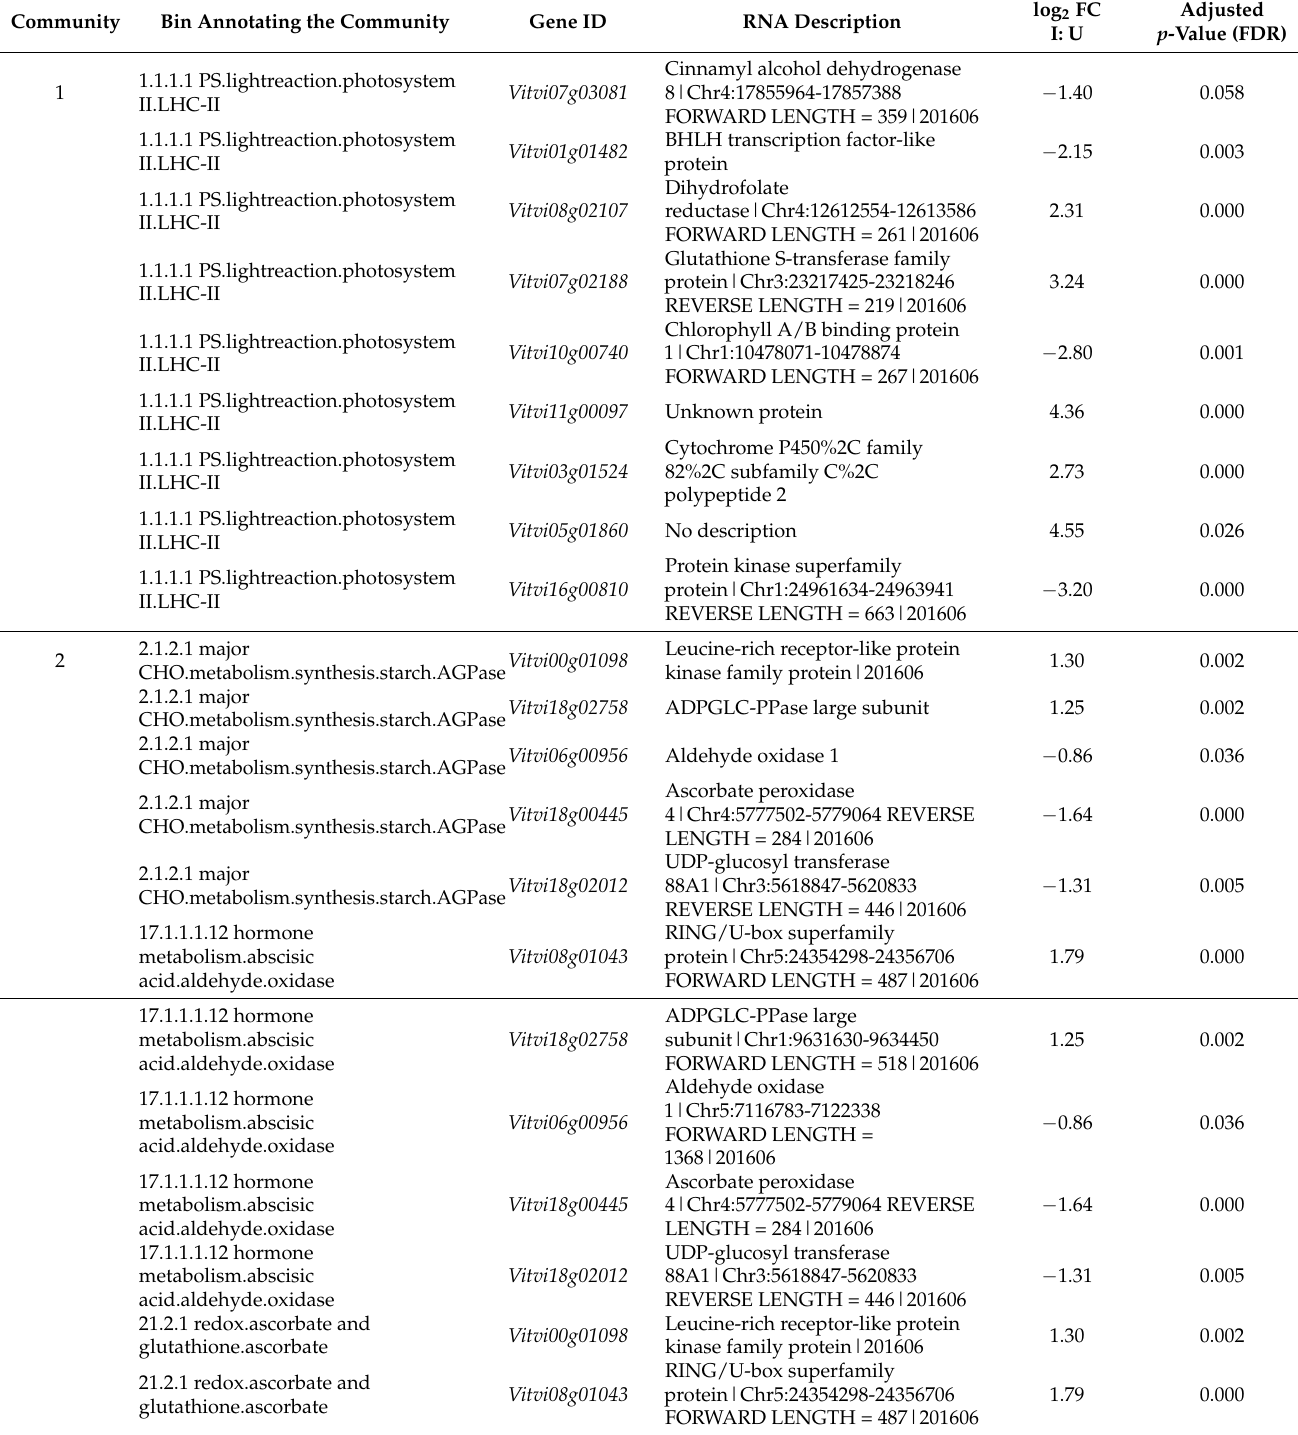
Table 1. Examples of the enriched communities with a direction of analysis from infected to uninfected grapevines late in the growing season, where the dissipation index was 0.48. Each community was annotated with the members from the GoMapMan ontology [38], providing direct insight into their associated processes. The analysed data were differentially expressed genes from uninfected grapevines cv. Zweigelt and from samples infected with ‘ Ca. P. solani’. For each mRNA sequence, the differences in expression between phytoplasma-infected and -uninfected plants were calculated as log 2 FC. Only mRNAs with a false discovery rate (FDR) adjusted p -value < 0.05 were considered as differentially expressed. U, uninfected samples; I, samples infected with ‘ Ca . P. solani’.